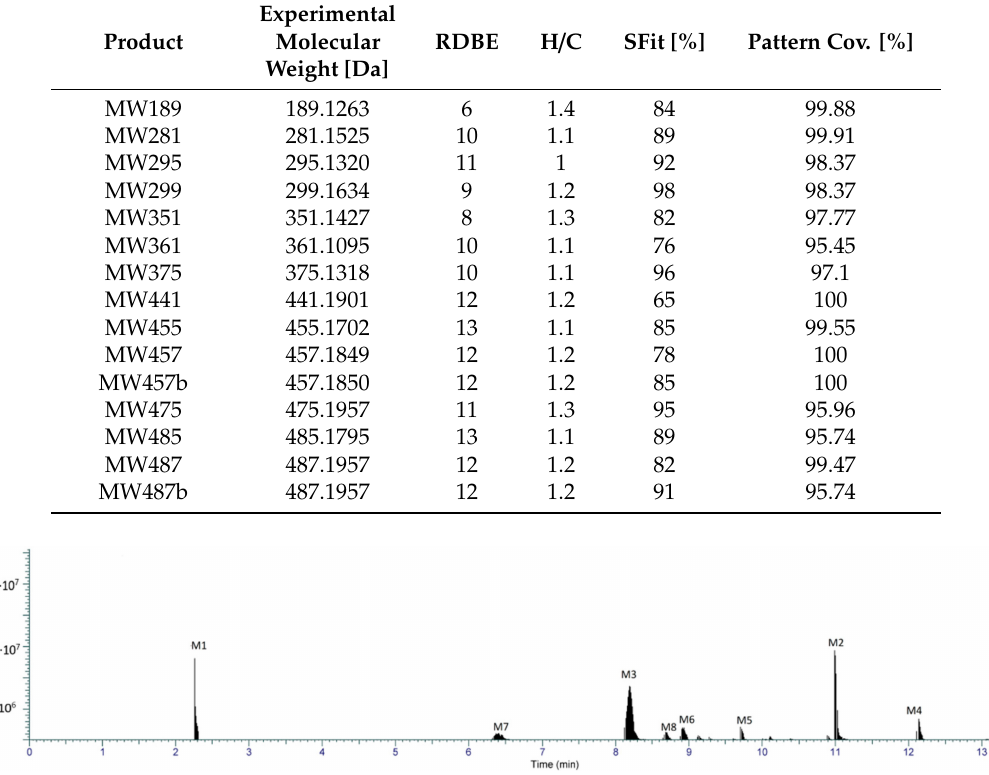
Figure A1. The example chromatogram of metabolites extracted from plasma of volunteers after administration of antazoline. Only the most prominent metabolites were